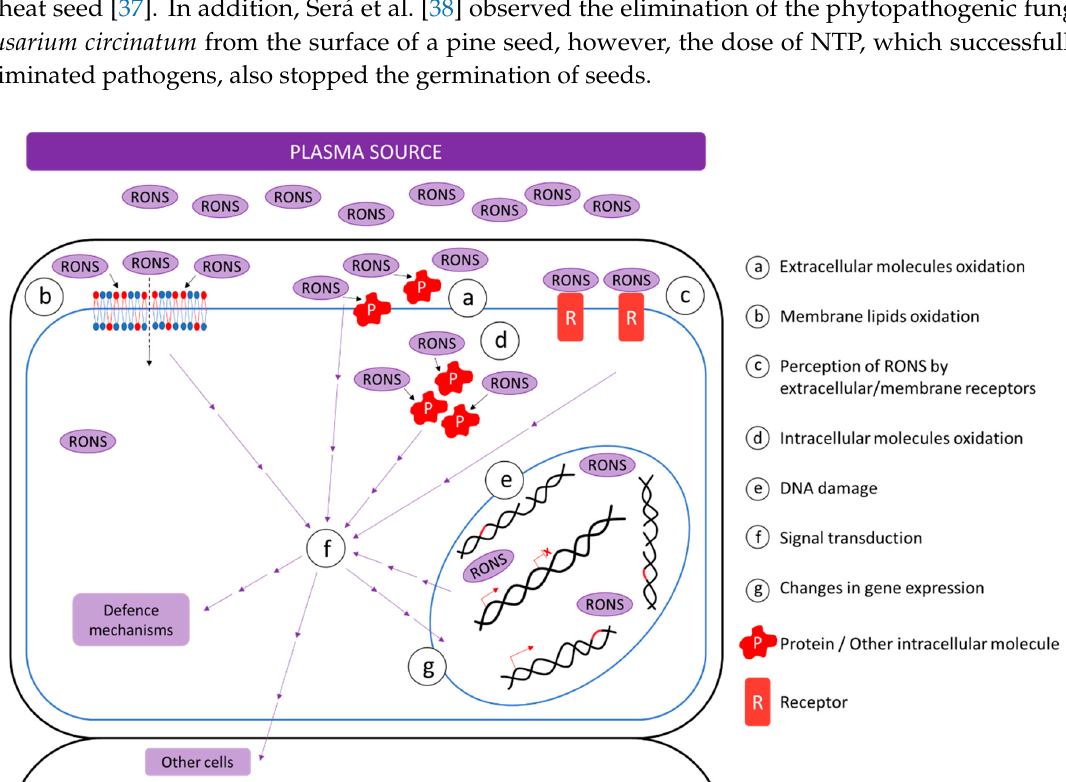
Figure 1. Illustration of possible interactions of non-thermal plasma (NTP) particles with cells. Reactive particles from plasma can oxidize molecules in the extracellular space or lipids in the cytoplasmic bilayer, as well. The latter could result in the creation of nanopores—a possible route for RONS to get inside the cell and oxidize molecules in the cytoplasm or get into the nucleus and cause DNA damage. Particles outside the cell can also interact with appropriate receptors. Oxidized molecules or membrane lipids, activated receptors, and damaged DNA can all transduce a signal about the increased amount of RONS, and the cell can react by changes in gene expression, activation of defence mechanisms, or signal transduction to other cells.